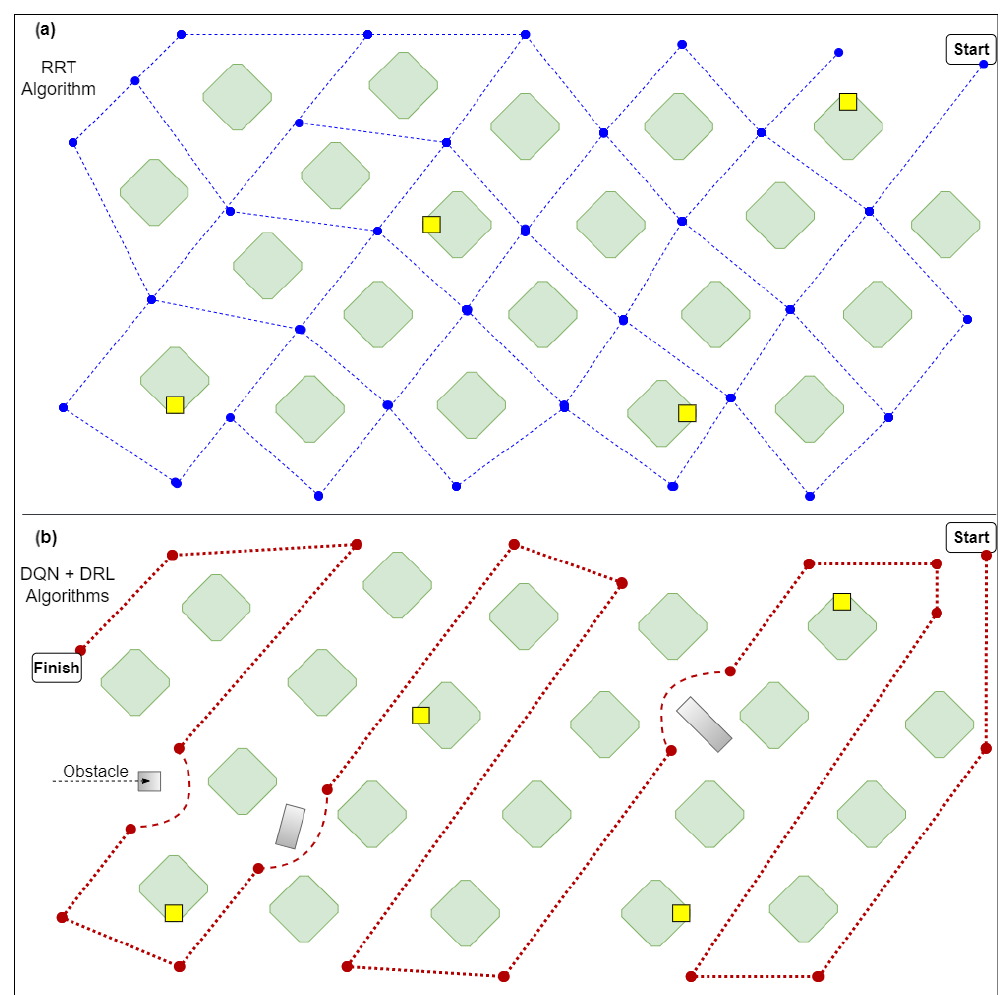
Figure 4. Overall idea of the proposed methodology. In Figure ( a ), the UAV starts the trajectory planning algorithm by exploring multiple path options in a complex and unstructured environment. Figure ( b ) illustrated when the RRT algorithm calculated all possible routes, and the optimized route planning was performed based on the DQN and DRL algorithms, making it possible to deal with changes in the environment in